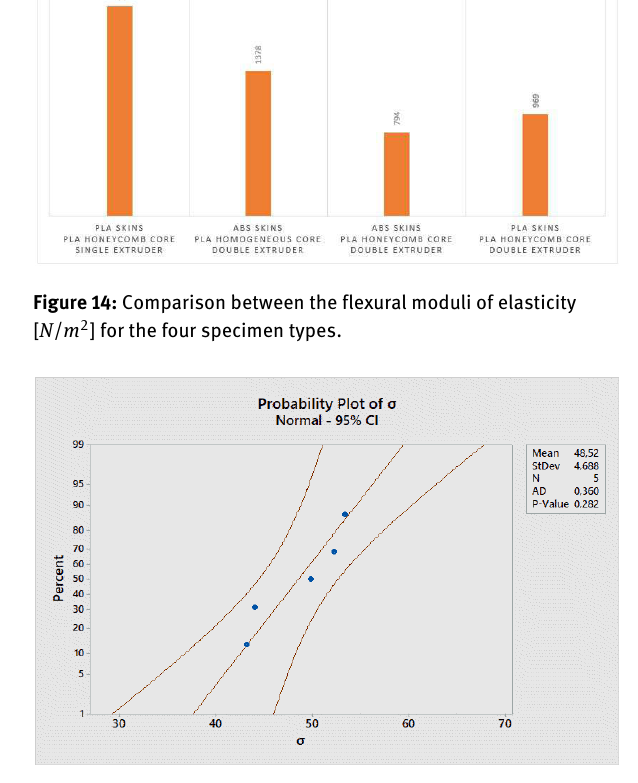
Figure 15: Probability plot of the flexural strength [ N / m 2 ] for speci- mens